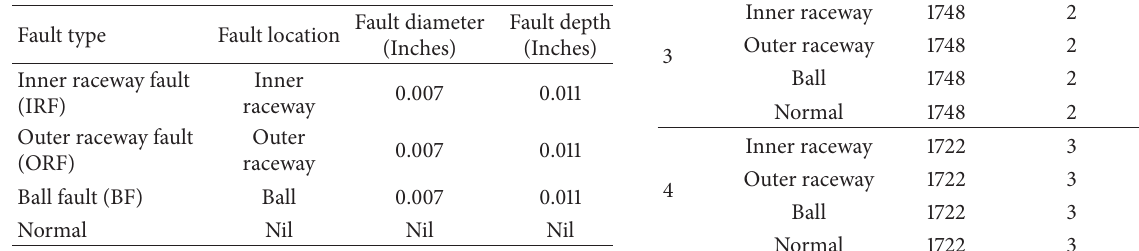
Table 2: Specifications of fault types.